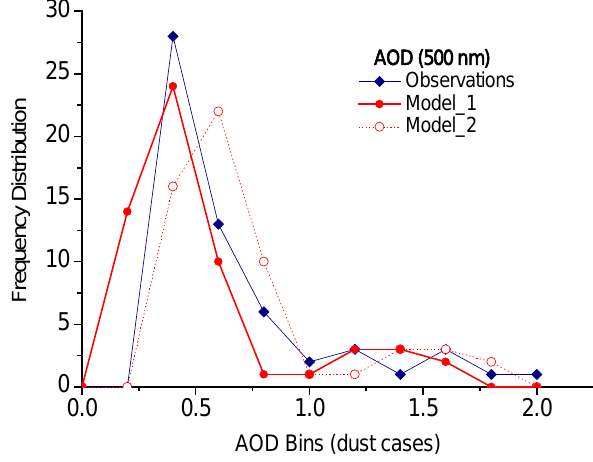
Fig. 4. Frequency distributions of observed AOD at 500nm and Figure 4. Frequency distributions of observed AOD at 500 nm and modelled AODs calculated modelled AODs calculated from BSC-DREAM dust loadings, ap- from BSC-DREAM dust loadings, applying the extinction cross-section value obtained from plying the extinction cross-section value obtained from our anal- our analysis. Model_1 and Model_2 correspond to the non-inclusion and inclusion, respec- ysis. Model 1 and Model 2 correspond to the non-inclusion and inclusion, respectively, of the calculated intercept that reflects an- tively, of the calculated intercept that reflects anthropogenic and other local contributions. thropogenic and other local contributions.